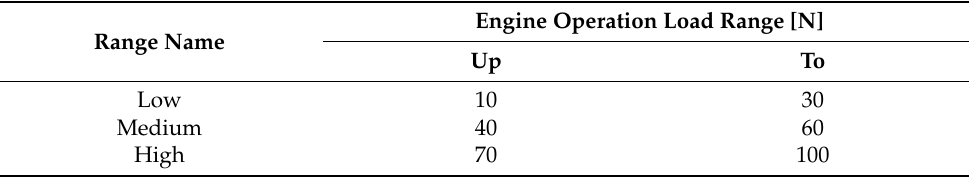
Table 6. Measurement ranges for engine operation load and their